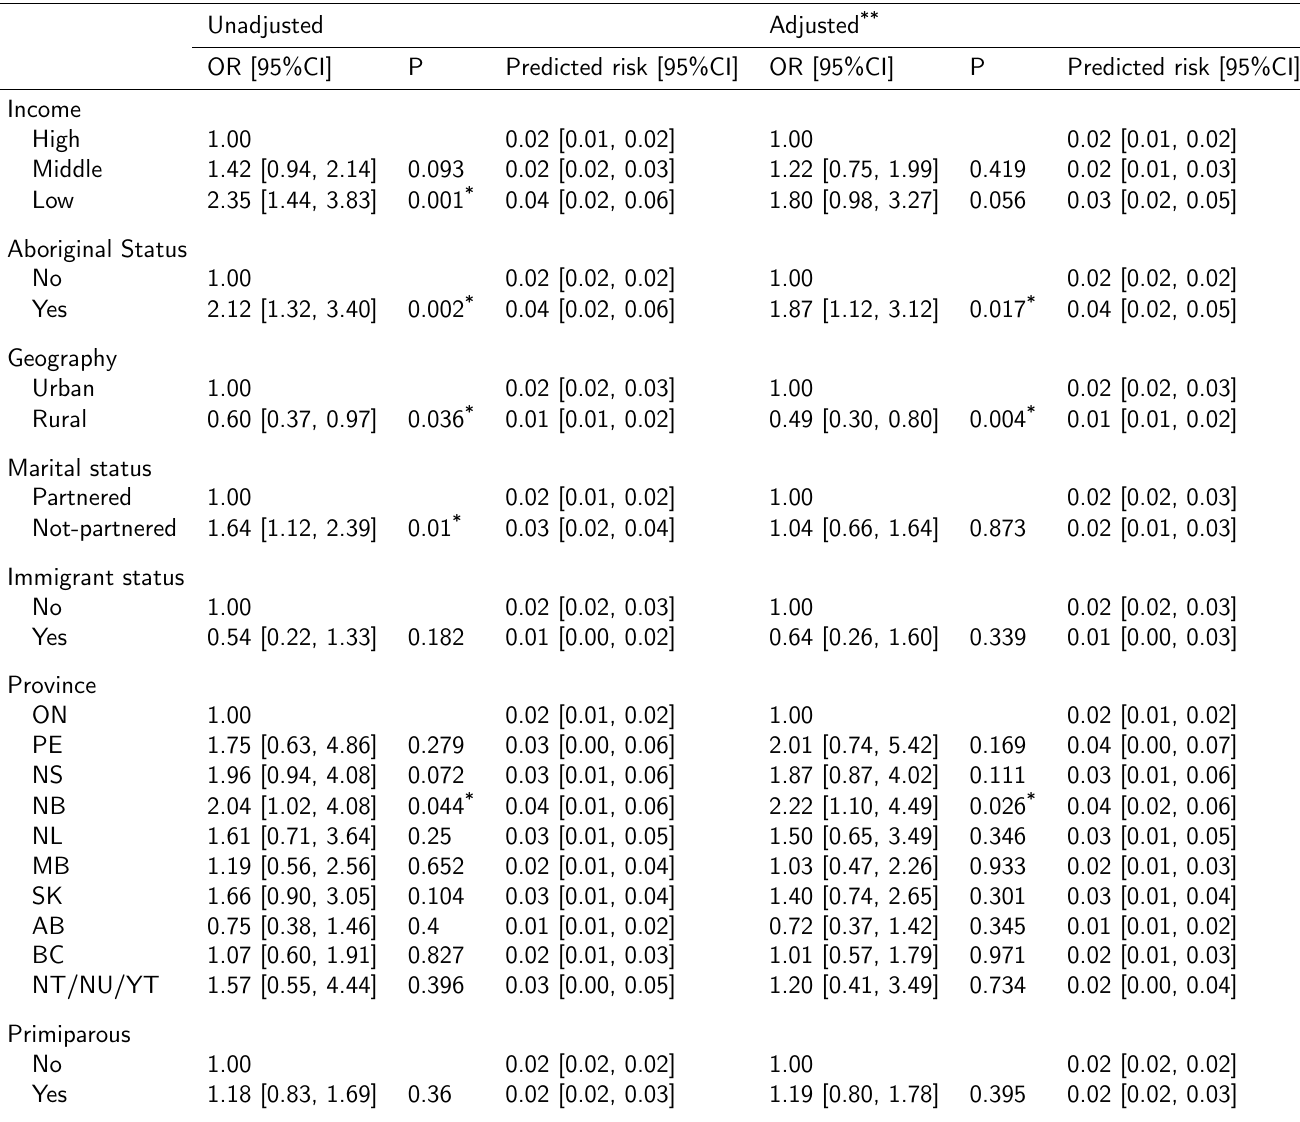
Supplementary Table 6 cont.: Odds ratios and risks of maternal readmission within 30 days of delivery Risk of readmission for Caesarian Delivery (n =